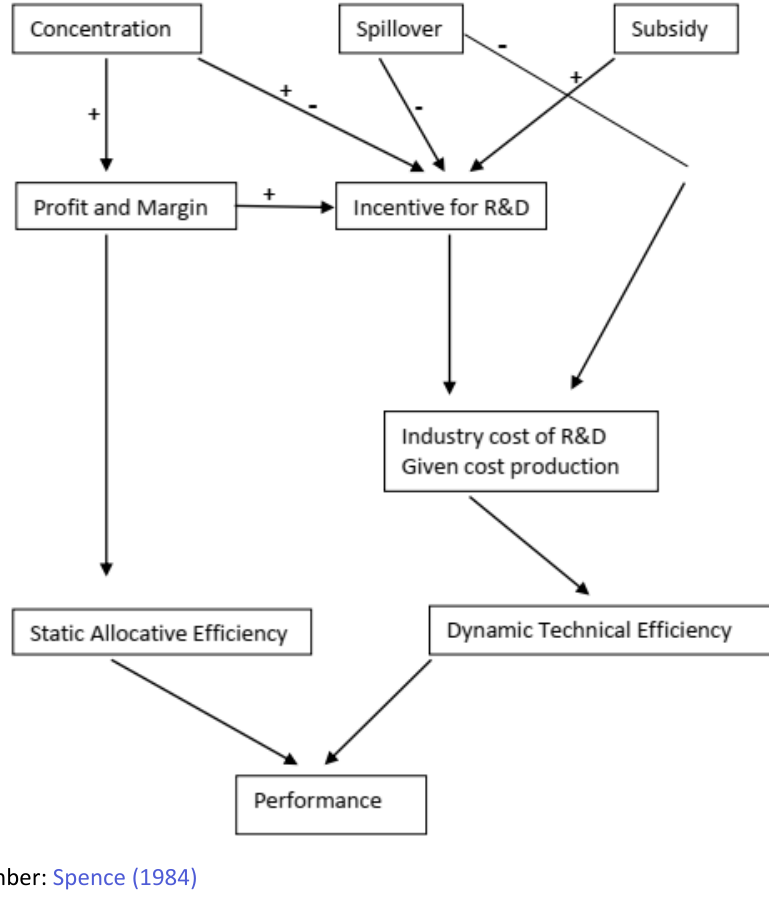
Figure 2: R&D Market